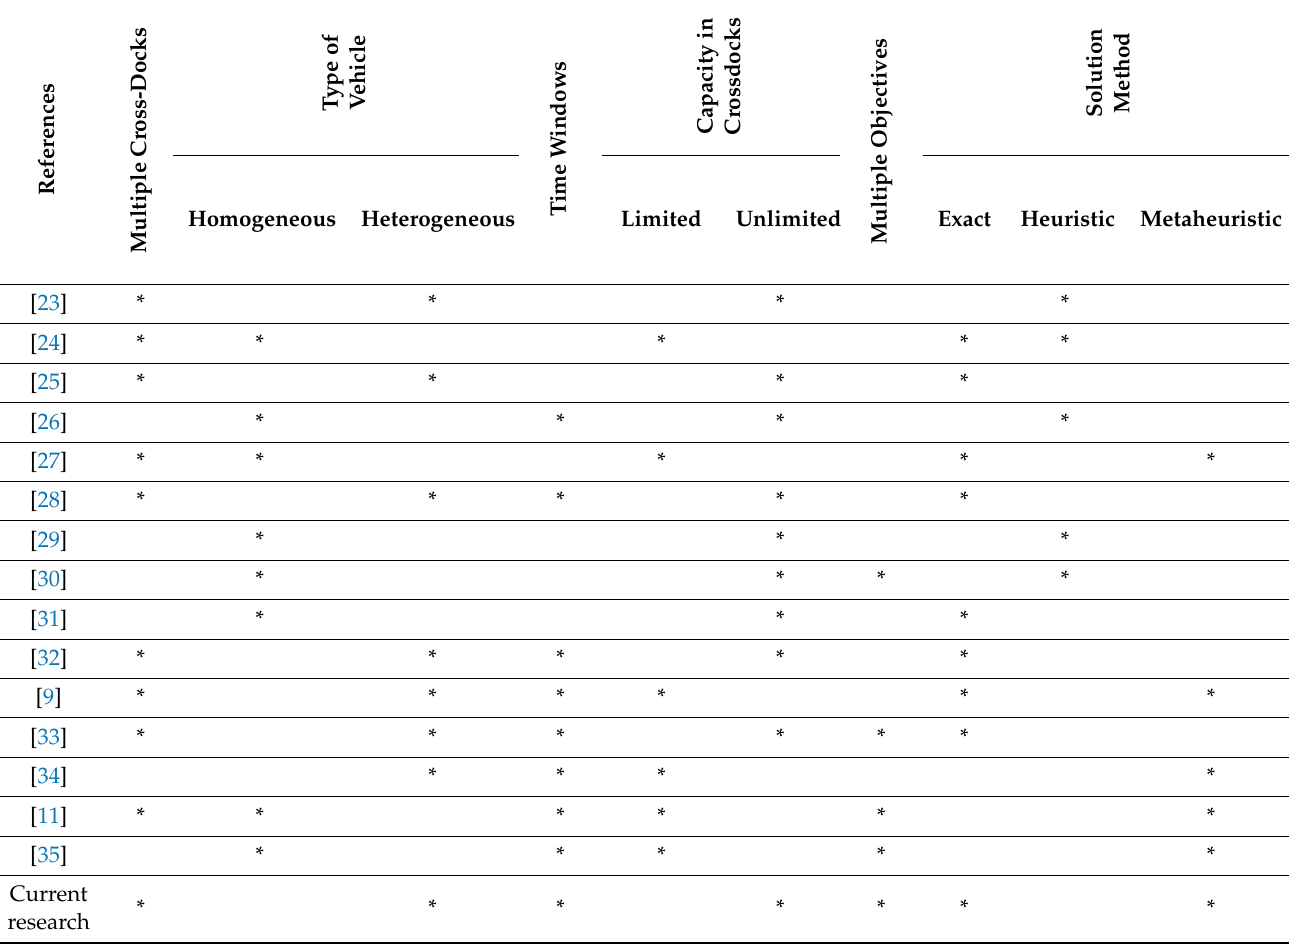
Table 1 summarize the literature regarding optimizing multi cross-docking systems (MCDS) and compare the existing problems with the problem proposed in this paper. Table 1. Summary of literature regarding MCDS and its different variants.